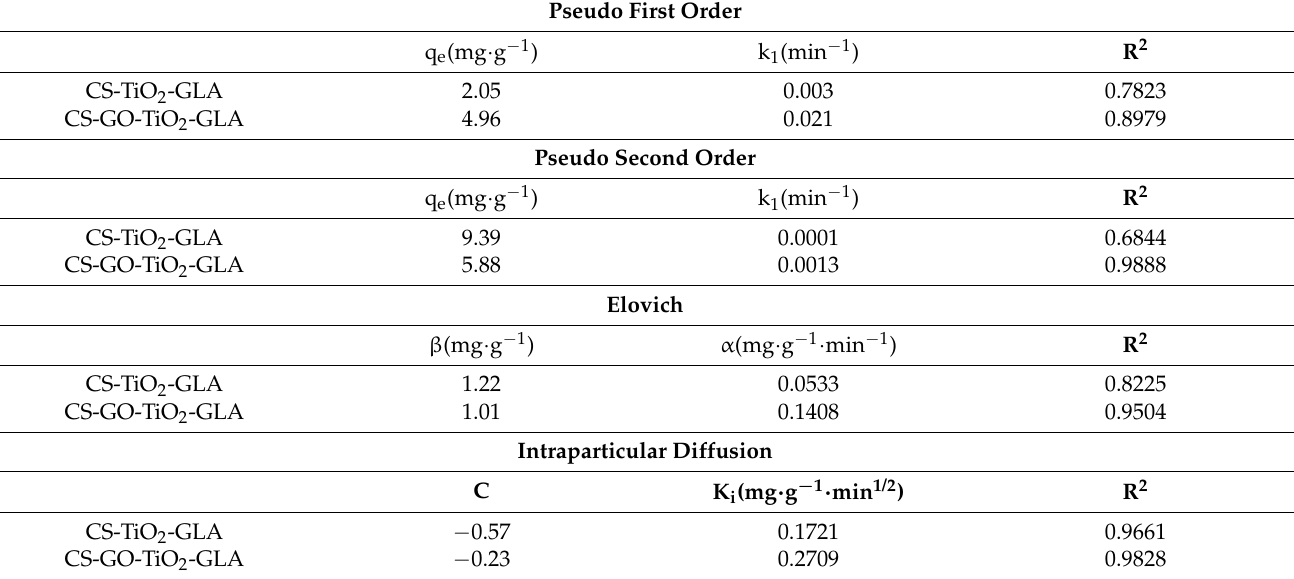
Table 8. Calculated parameters of the different kinetic models for the adsorption of FD&C Red 40 dye on the two adsorbent